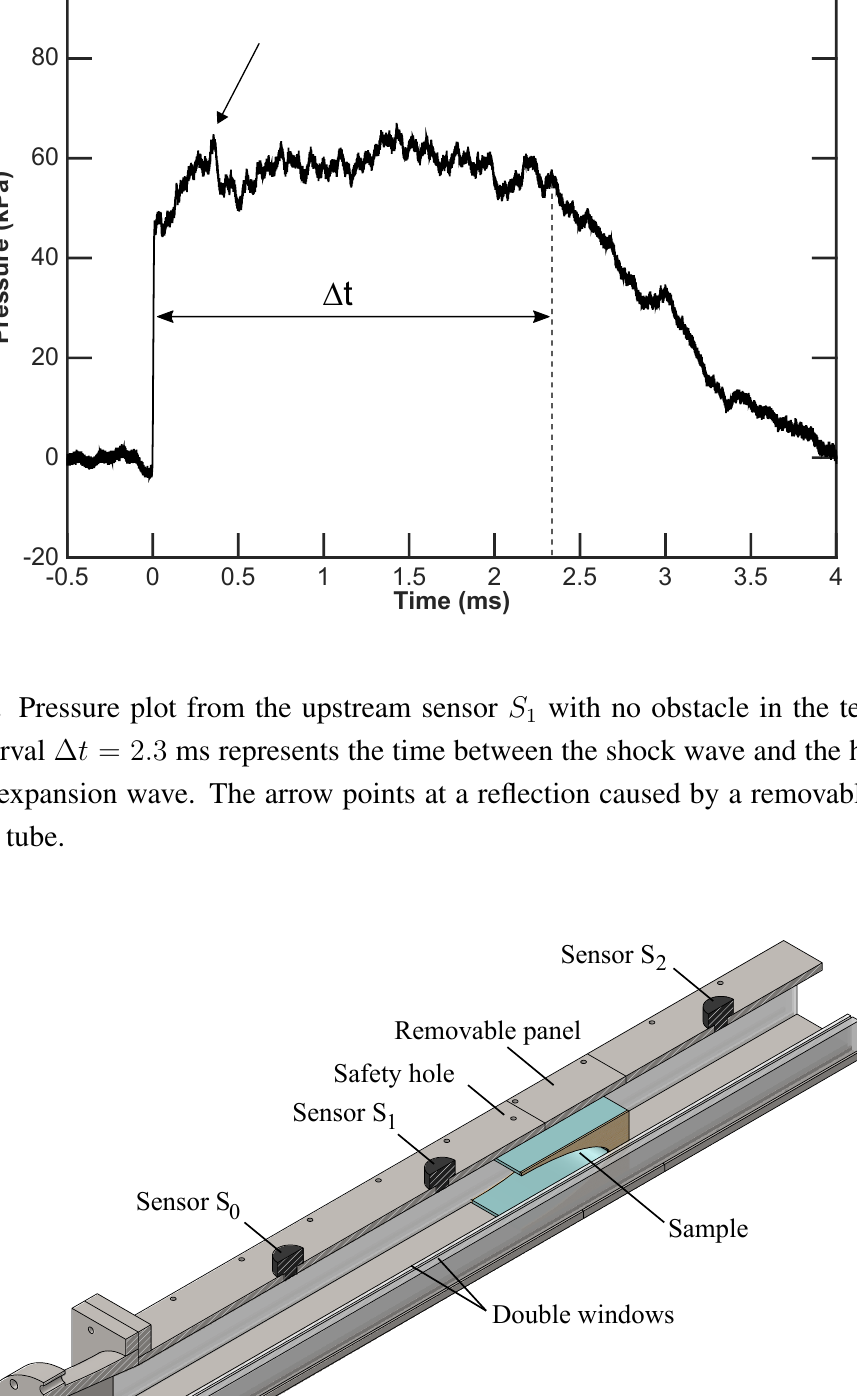
Figure 5. Sectional view of shock tube test section with transition section, sensor and sample